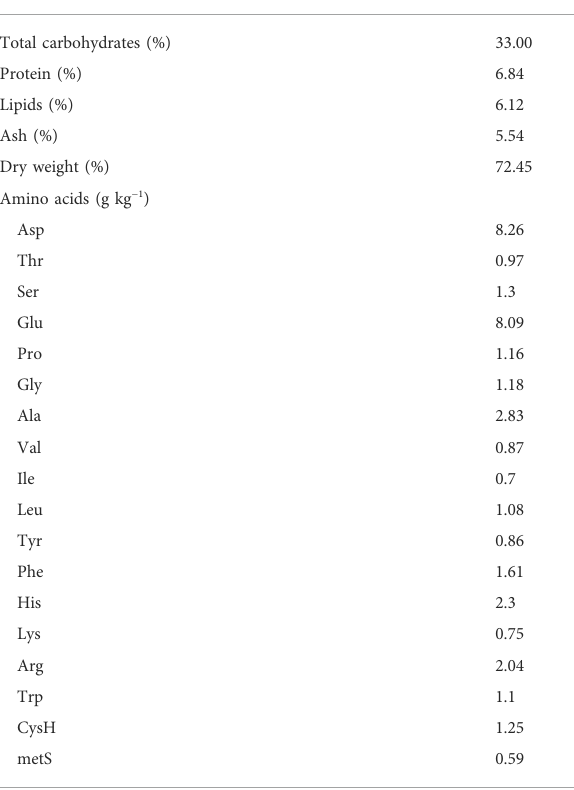
TABLE 2 Composition of soybean molasses used in the presented